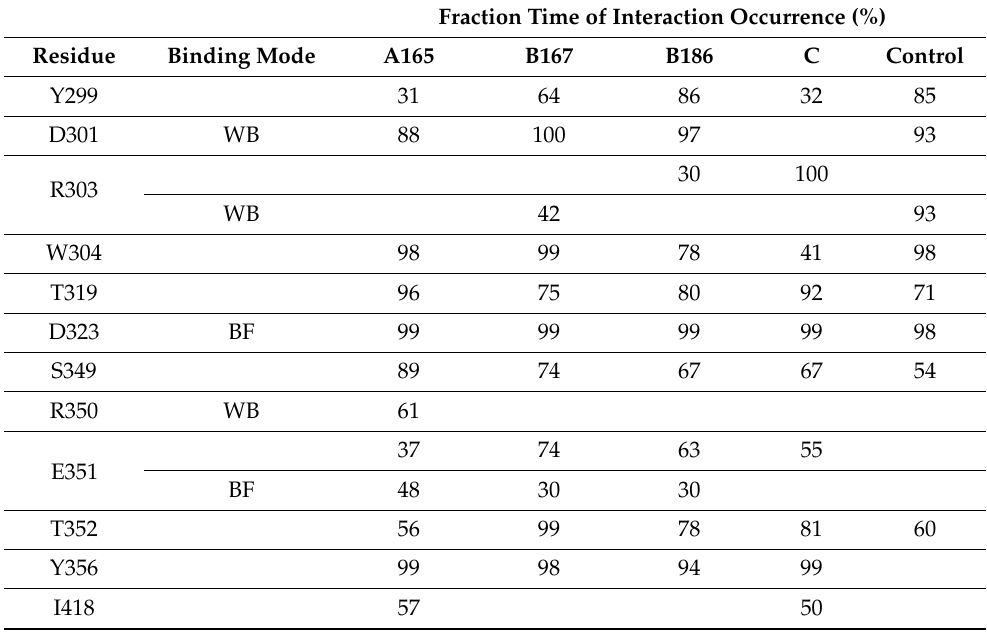
Table 5. Interaction of peptides with NRP2 deconvoluted as a fraction time of contact occurrence per protein residue during 30 ns production